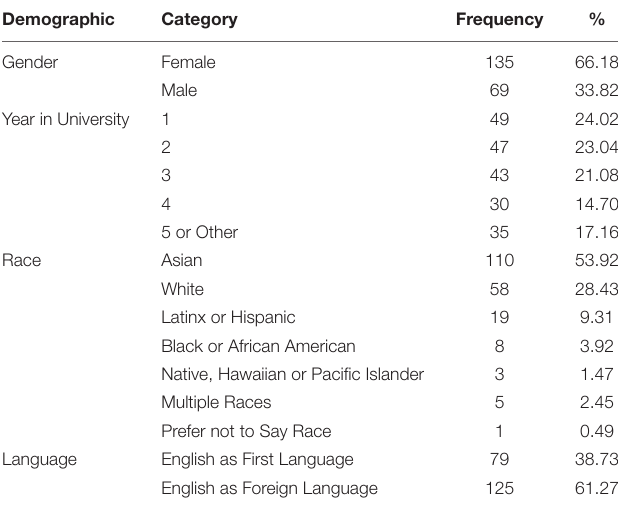
TABLE 1 | Demographic characteristics of the sample.